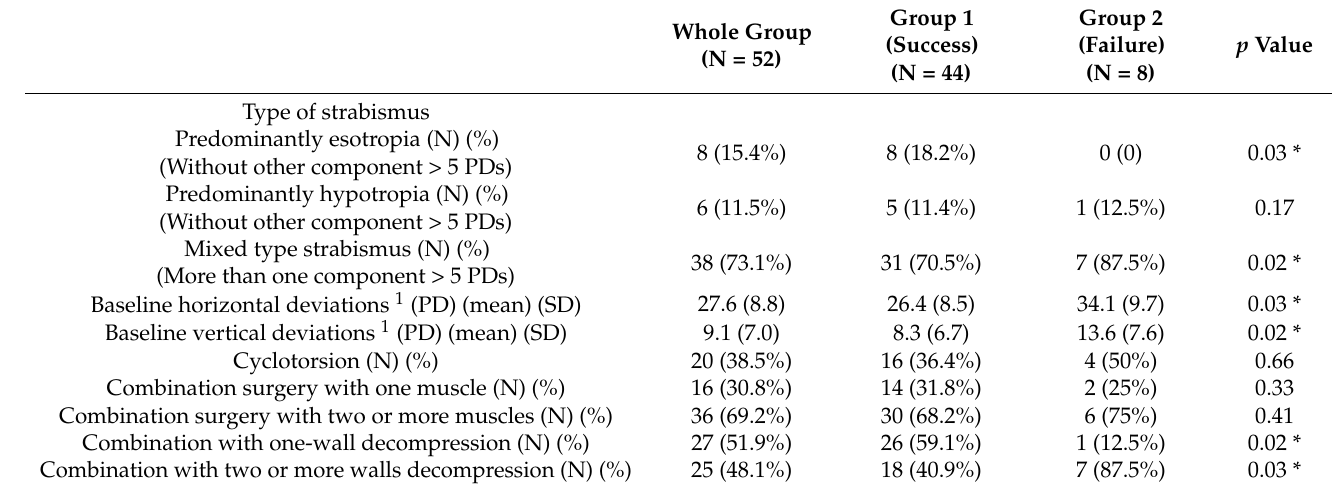
Table 3. Perioperative examinations of the patients in the